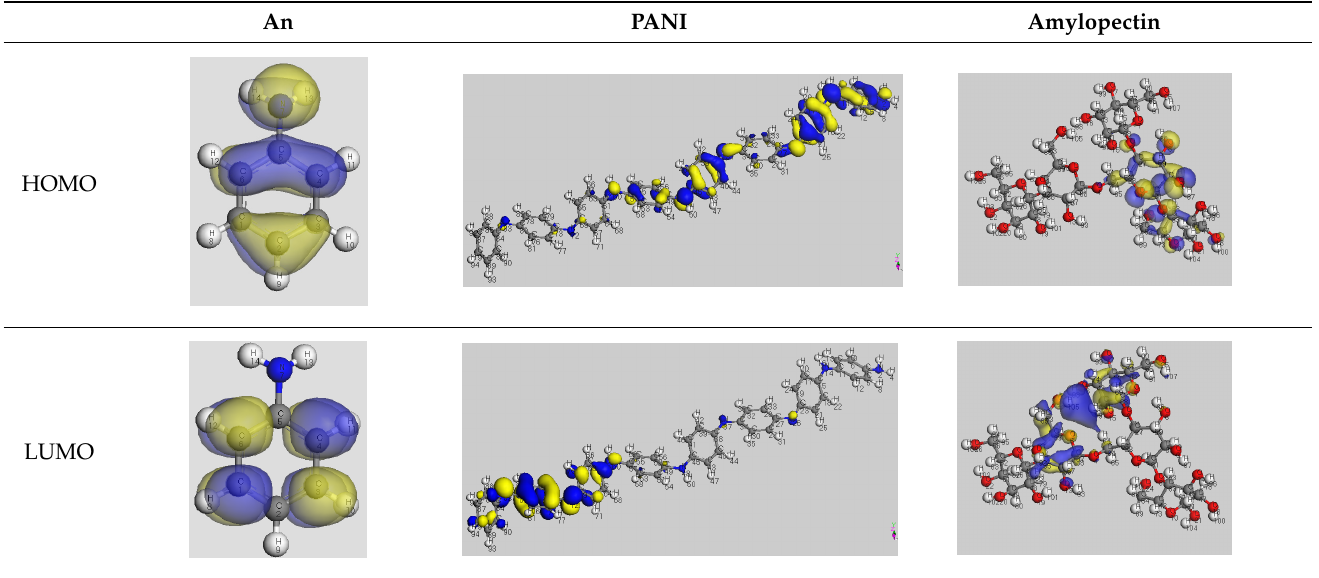
Table 10. The HOMO and LUMO electron density distributions of aniline, polyaniline, and amylopectin.